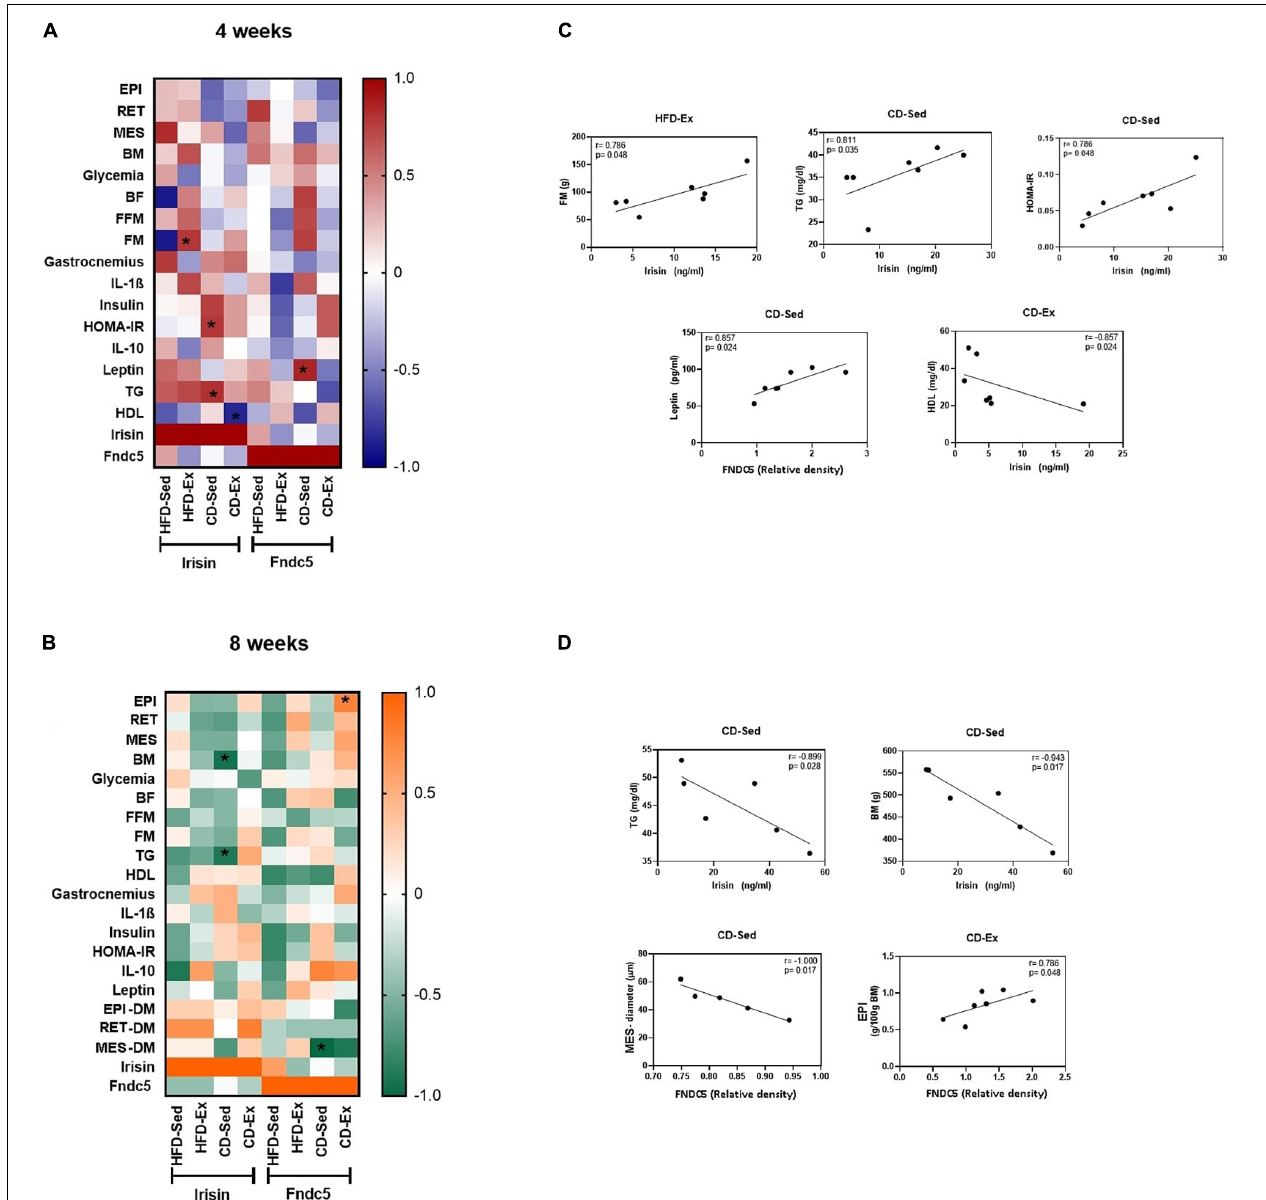
FIGURE 8 | Spearman’s correlation coefficient between irisin/FNDC5, body composition and biochemical parameters after 4 and 8 weeks of intervention. (A) Heatmap of Spearman’s correlation coefficient between irisin/FNDC5, body composition and biochemical parameters after 4 weeks of intervention. (B) Heatmap of Spearman’s correlation coefficient between irisin/FNDC5, body composition and biochemical parameters after 8 weeks of intervention. (C) Spearman’s correlations that were significant between irisin/FNDC5 and the study variables after 4 weeks of intervention. (D) Spearman’s correlations that were significant between irisin/FNDC5 and the study variables after 8 weeks of intervention. EPI: epididymal adipose tissue; RET: retroperitoneal adipose tissue; MES: mesenteric adipose tissue; BM: body mass; BF: body fat; FFM: fat-free mass; FM: fat mass; HOMA-IR: Homeostatic model assessment; TG: triglycerides; HDL: high density lipoprotein; IL-1 β : interleukin 1-beta; IL-10: interleukin 10; AR: area; DM: diameter. HFD-Ex: high-fat diet and exercise; HFD-Sed: sedentary high-fat diet; CD-Ex: chow diet and exercise; CD-Sed: sedentary chow diet. Individual values were plotted on the graphs. Statistical significance: p <